Question: Give a one-sentence summary of this figure.
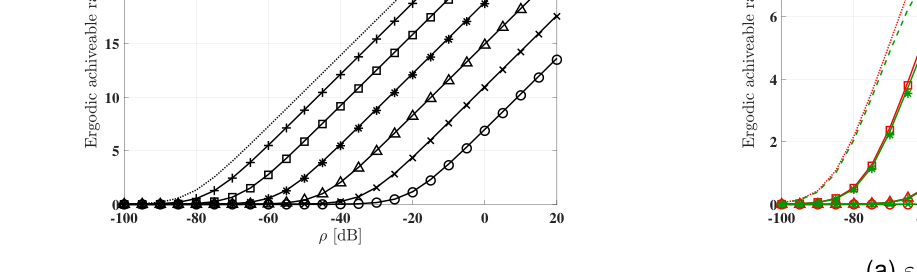
Answer: Theoretical analysis (29), (34) and simulation results of the ergodic achievable rate R versus the transmit power ρ for different number of RHS elements, with perfect RHS phase shift design and ideal hardware quality of the RF chains at the BSs and UEs.